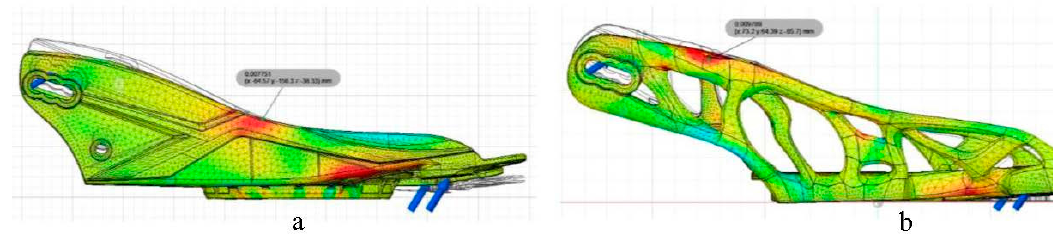
Figure 6. FEM simulation of the deformation in plantarflexion (horizontal axis) of the commercial binding ( a ) and of the prototype ( b ).